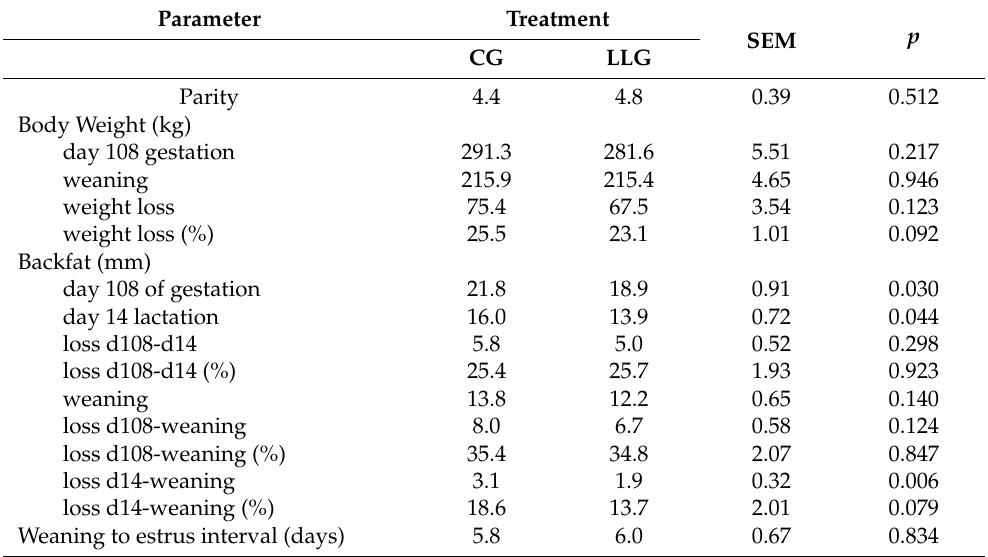
Table 2. Reproductive performance parameters of sows according to treatment ( n = 30 per treatment).